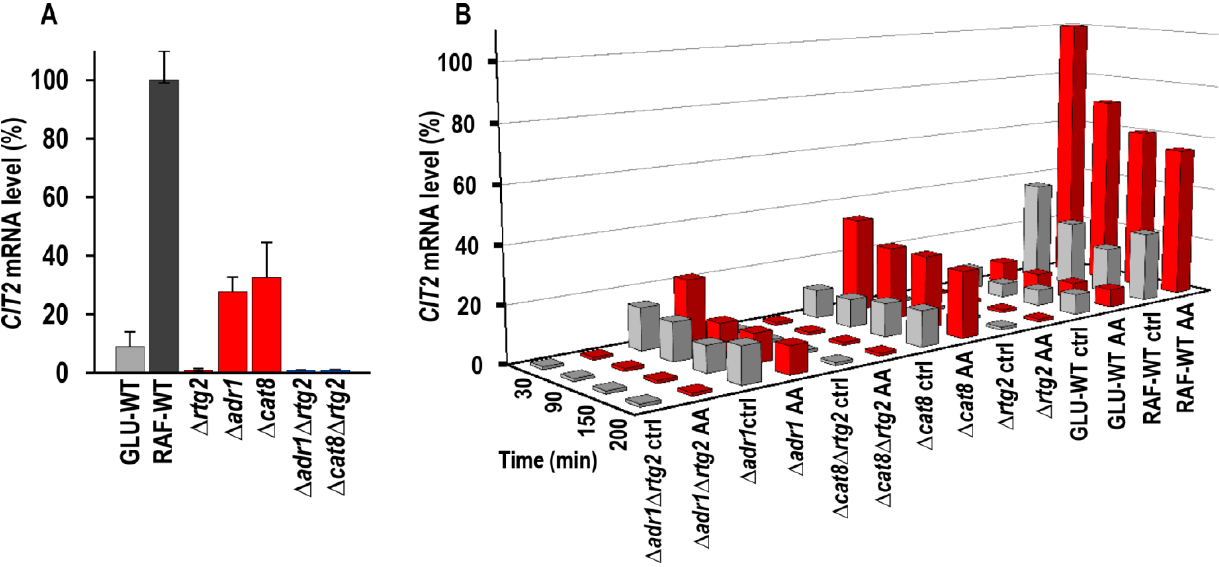
FIGURE 3: CIT2 mRNA level in raffinose-grown wild-type and mutant strains in exponential phase growth and en route to acetic acid treatment. (A) CIT2 mRNA levels were measured by real-time PCR in RAF-WT cells and in deletion mutant cells grown in raffinose medium and collected in exponential phase (OD 600 0.6-0.7). GLU-WT cells were also analyzed as control. Percentage of CIT2 mRNA levels, normalized to ACT1 mRNA, as compared with that in RAF-WT cells (100%), was reported. (B) CIT2 mRNA levels were measured by real-time PCR at the indicated time points in wild-type and mutant strains grown in raffinose medium with (AA, red bars) or without (ctrl, grey bars) the supple- mentation of 80 mM acetic acid . GLU-WT samples were included as controls. Percentage of CIT2 mRNA levels, normalized to ACT1 mRNA, as compared with that in AA-treated RAF-WT cells at 30 min, was